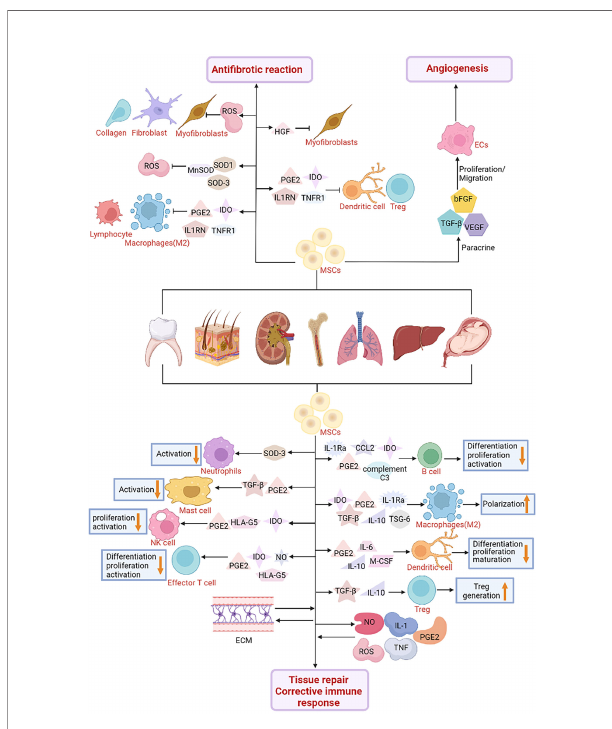
FIGURE 4 | The role of Mesenchymal Stroma Cells (MSCs) in cell engineering technology. MSCs are used in cell therapy and might play a role in the treatment of diabetes. MSCs interact with immune cells such as natural killer cells (NK), macrophages, neutrophils, mast cells and dendritic cells. MSCs secrete a variety of soluble factors, Indoleamine 2, 3-dioxygenase (IDO), prostaglandin E2 (PGE2), C-C motif chemokine Ligand 2 (CCL2), IL-1 receptor antagonist (IL-1RA), complement C3, Tumor necrosis factor- (TNF) stimulated gene-6 (TSG-6), Transforming growth factor b (TGF- b ), interleukin- 10 (IL-10), interleukin-6 (IL-6), macrophage Colony stimulating factor (M-CSF) and human leukocyte antigen-G5 (HLA-G5) can inhibit the differentiation, proliferation and activation of various immune cell subgroups. Furthermore, MSCs interact with in fl ammatory factors including nitric oxide (NO), PGE2, tumor necrosis factor (TNF), reactive oxygen species (ROS), interleukin-1 (IL-1) and extracellular matrix (ECM) to promote tissue regeneration, repair and correct abnormal immune responses. In terms of the regulation of fi brosis microenvironment, MSCs release IDO, PGE2, interleukin-1 receptor antagonist (IL1RN), tumor necrosis factor receptor-1 (TNFR1) and other immunosuppressive factors to inhibit the activation of immune cells and the in fi ltration of in fl ammatory sites, and promote the formation of regulatory T (Treg) cells. In addition, MSCs produce antioxidant enzymes such as superoxide dismutase 1 (SOD1) and 3 (SOD3) and manganese superoxide dismutase (MnSOD) to reduce oxidative stress and reactive oxygen species levels. In addition, MSCs also secrete hepatocyte growth factor (HGF) and PGE2 in different ways to promote myo fi broblast apoptosis and inhibit fi broblast proliferation and collagen production, respectively, thereby inhibiting the fi brotic response. It has also been found in diabetes studies that MSCs can secrete vascular endothelial growth factor (VEGF), basic fi broblast growth factor (bFGF), TGF- b and other angiogenic factors. Promotes the formation of new blood vessels and protects the islets from blood-mediated in fl ammatory response